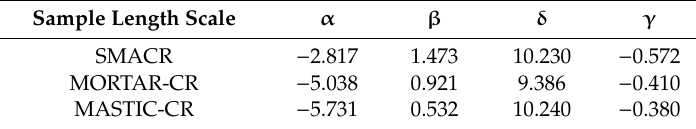
Table 11. Sigmoidal complex modulus model parameters.